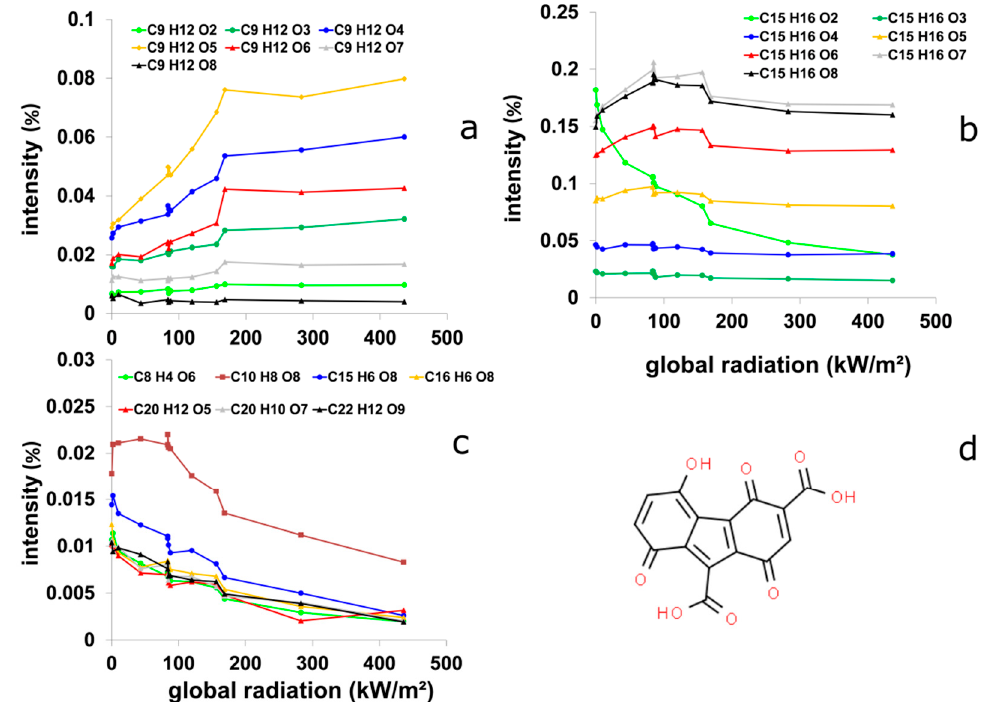
Figure 7. Homologous O—series with mainly monotonous increasing intensities versus cumulated radiation ( a ), homologous O—series with di ff erent intensity variation ( b ) and homologous O—series with mainly monotonous decreasing intensities ( c ). Possible structure ( d ) for C 15 H 6 O 8 present in ChemSpider.